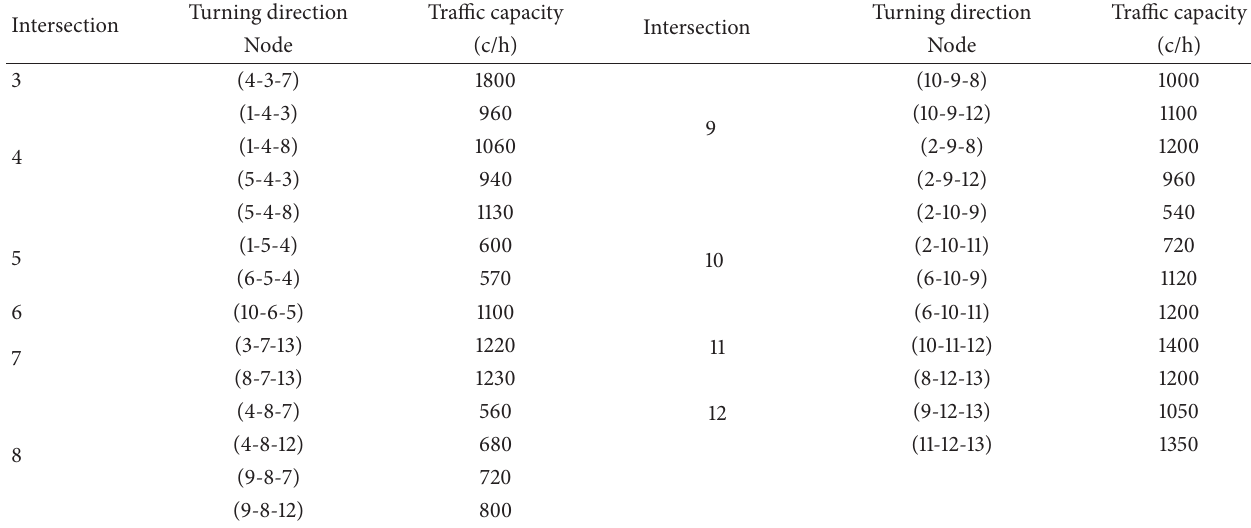
Table 2: Traffic capacity at turning